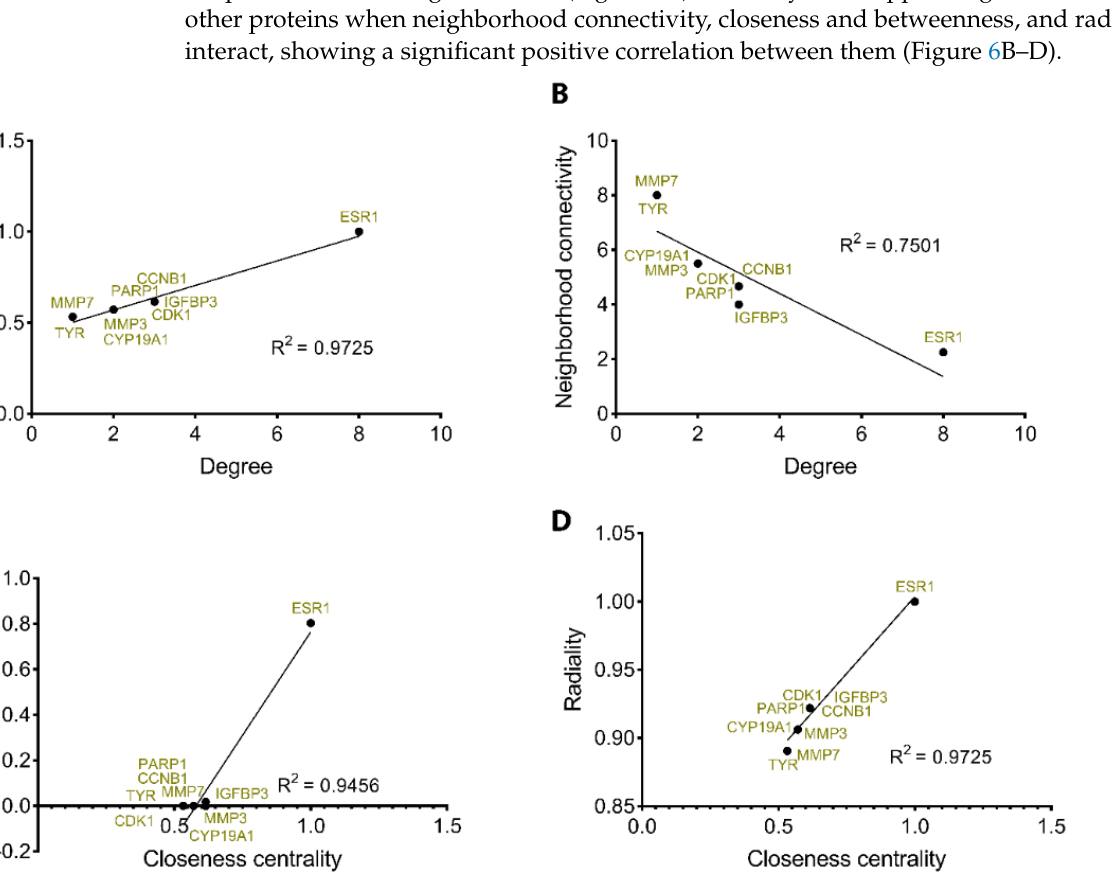
Table 1. Parameters used to evaluate 11 common proteins between phlorizin, phloretin, and TBI in protein–protein interaction analysis by Cytoscape. Protein Degree ESR1